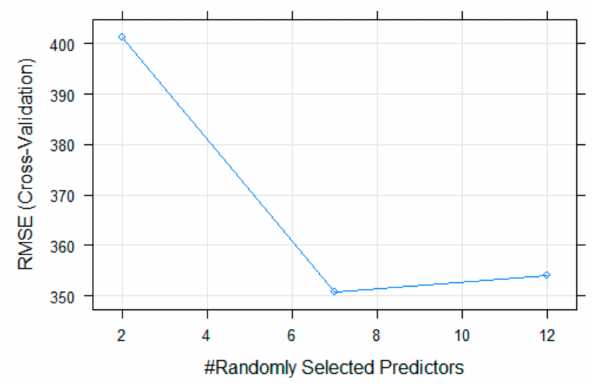
Figure 2. Random forest model plot.